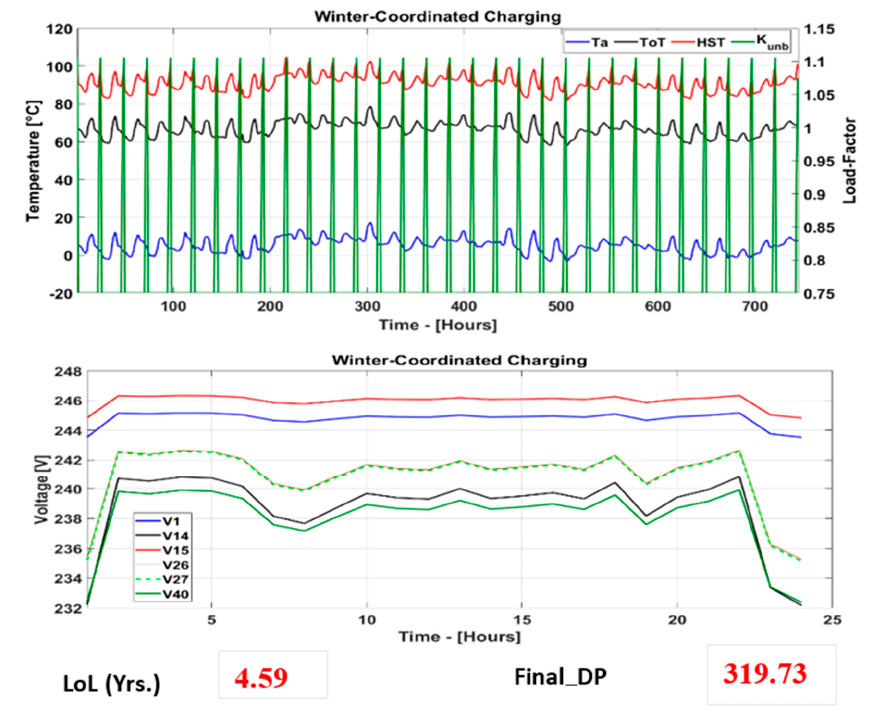
Figure 8. Output under coordinated charging across selected households, during winter, with BESS.